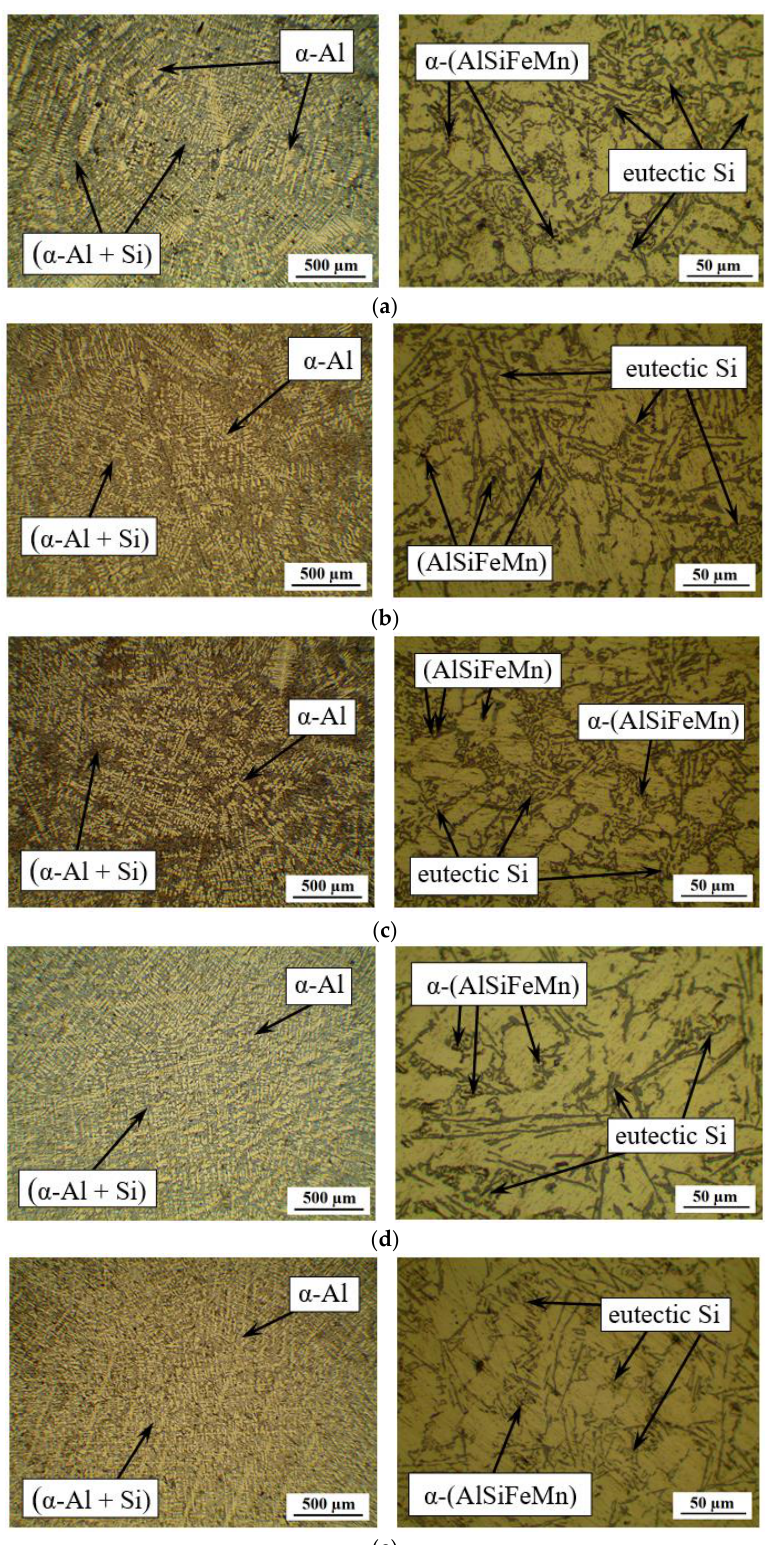
Figure 2. Microstructure of Al-12%Si alloy with different content of W: initial state (0 mass % of W), ( a ); 0.01 mass % of W, ( b ); 0.05 mass % of W, ( c ); 0.1 mass % of W ( d ); 0.5 mass % of W ( e ).